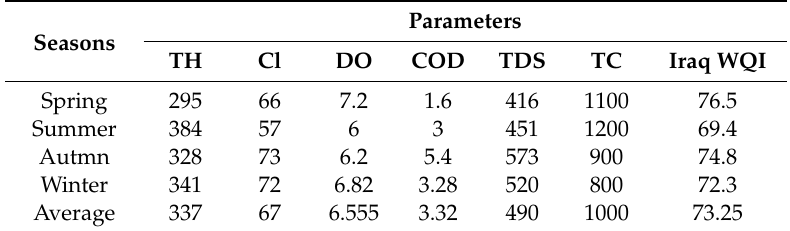
Table 4. Application of the proposed index to the seasonal measurements of the Tigris River within Baghdad.